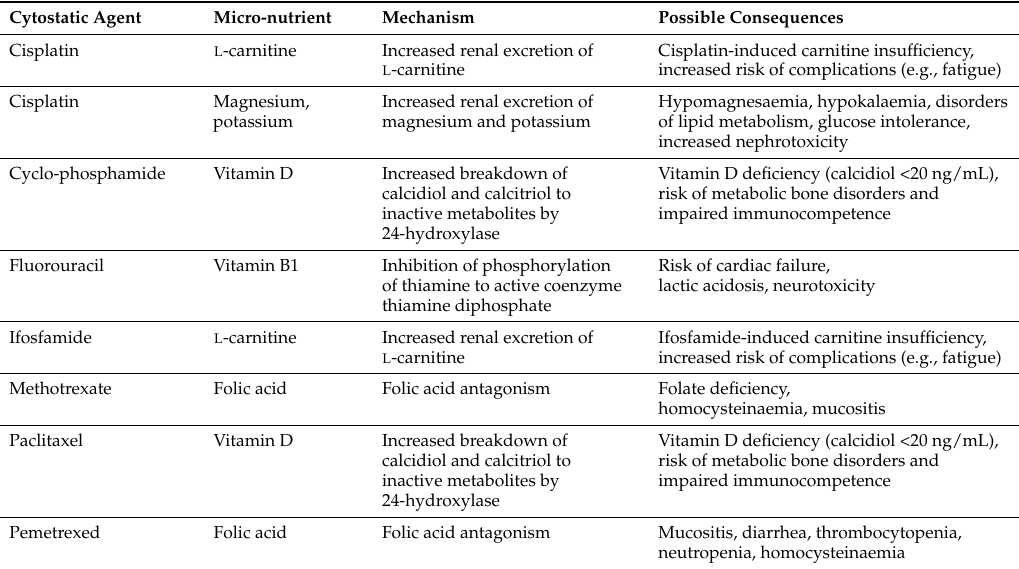
Table 2. Specific chemotherapy-induced micronutrient imbalance (selection)